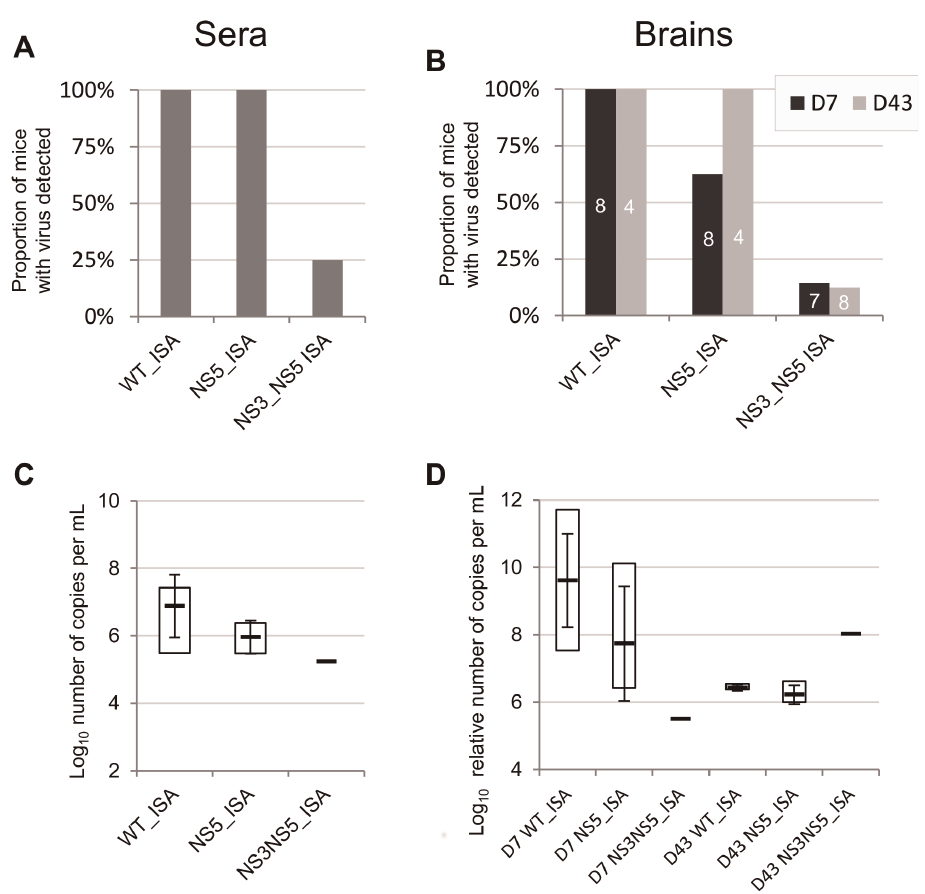
Fig 2. Proportion of mice with virus detected in the serum (A) or in the brain (B) and viral RNA yields in sera (C) and in the brain (D) by qRT-PCR. For each group, four sera were sampled at 2 days pi. Brains were samples at 7 and 43 days pi (D7 and D43 in panels B and D ; the number of mice sampled for each time point is indicated onto each bar in panel B ). Viral RNA yields are expressed as log 10 number of copies per mL (sera) or log 10 relative number of copies per mL (brains) (values were normalized using the housekeeping gene HMBS as detailed in the Materials and Methods section). For viral RNA yields, white squares represent minimal and maximal values. Black lines and error bars represent mean values +/- standard